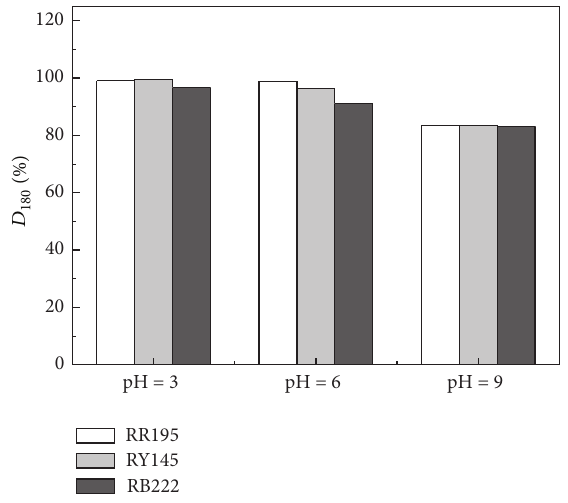
Figure 3: Relationship between pH and 𝐷 180 % value.